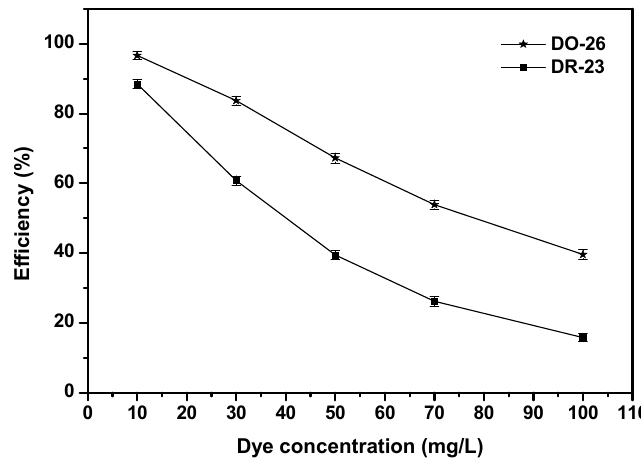
Figure 12. Effect of the initial concentration of Direct Orange 26 or Direct Red 23 on the photocatalytic degradation of Direct Orange 26 or Direct Red 23.